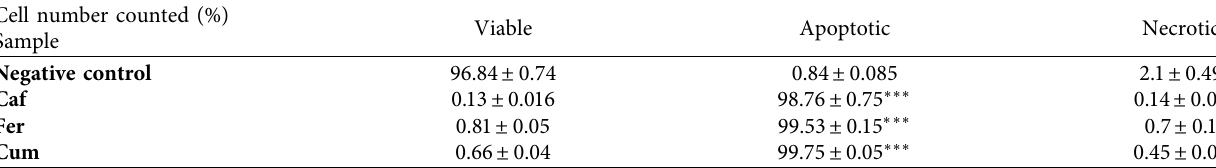
Table 3: Effects of phenolic acid treatment on cell